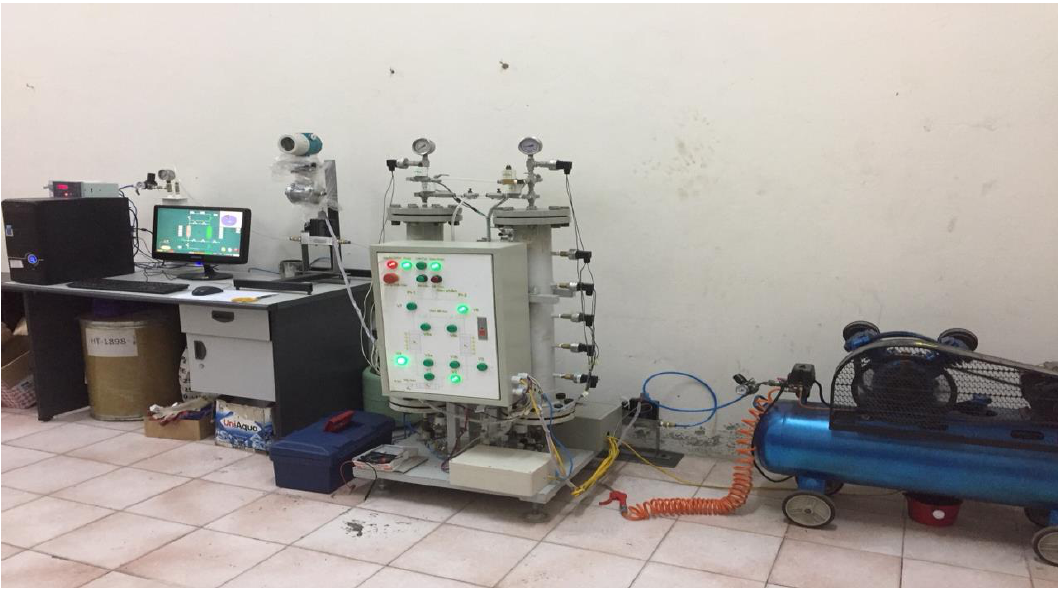
Figure 3. The experimental equipment system.